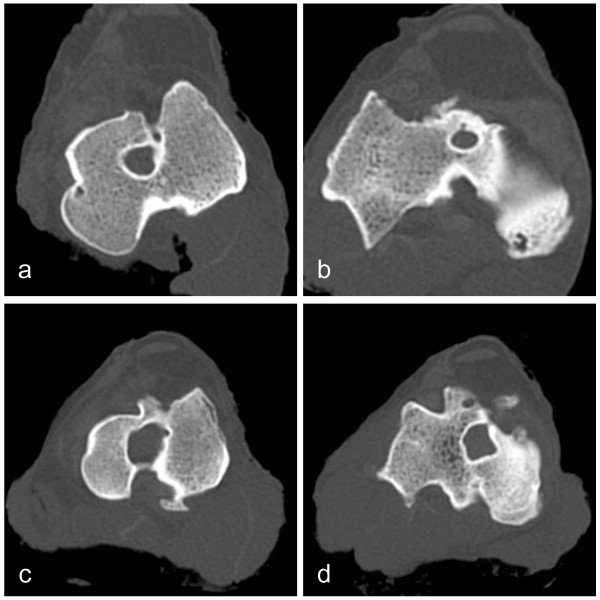
CT images of cross-sectional area of tunnel. (a) Femoral bone tunnel in CaP group. (b) Tibial bone tunnel in CaP group. (c) Femoral bone tunnel in control group. (d) Tibial bone tunnel in control group. The femoral and tibial bone tunnels in the control group showed greater enlargement than those in the CaP group.